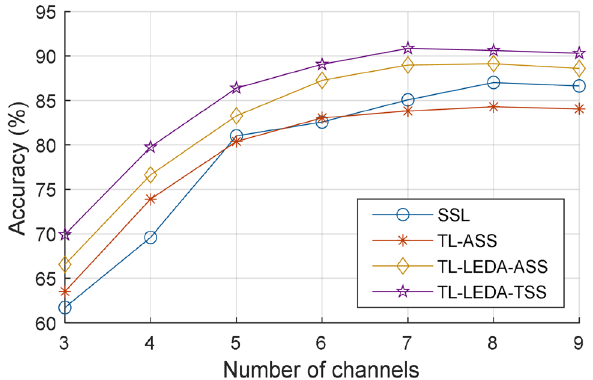
Figure 6. Relationship between the averaged accuracy across subjects and the number of channels used for target recognition for the four algorithms SSL, TL-ASS, TL-LEDA-ASS and